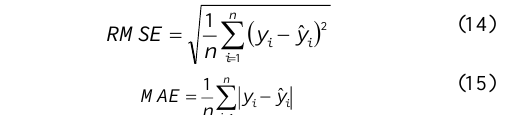
Table 7. Model accuracy of proposed models and baseline models for 8-hour